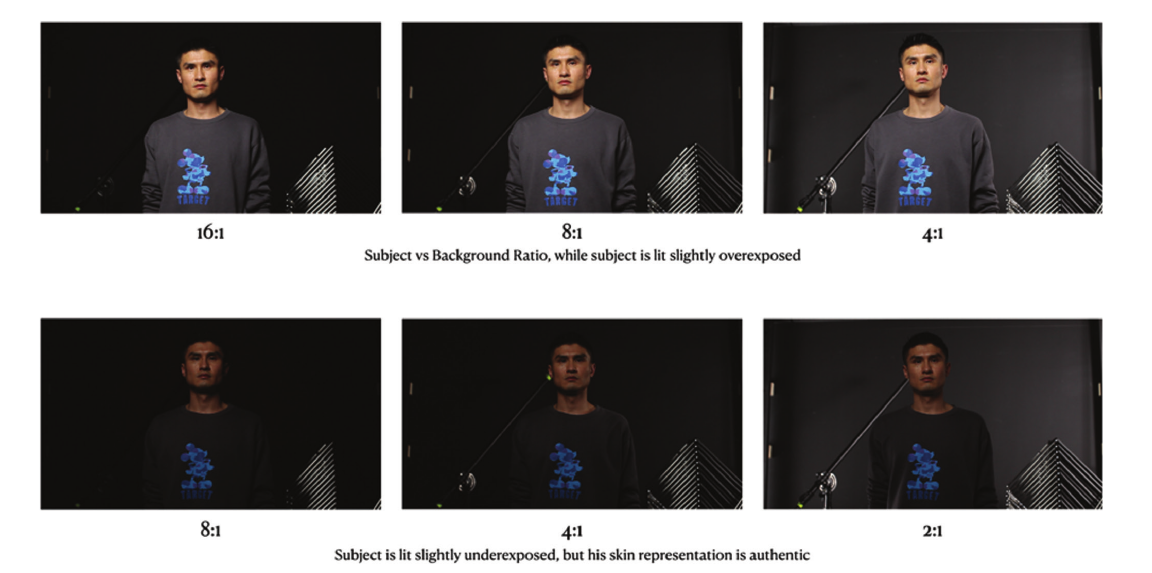
Figure 3. Adjusting the key light output for two skin tone representations while modifying background separations. The top three images are lit for representing paler skins; the bottom three images for authentic skin representation, as the subject has darker complexions (Source: Author,